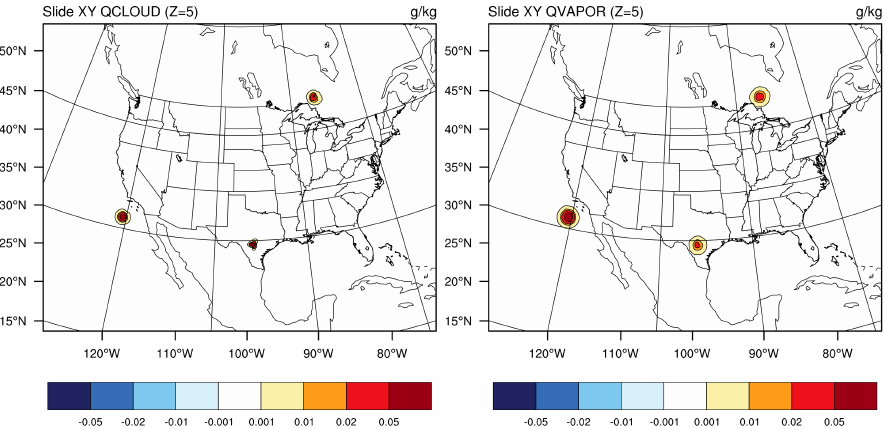
Figure 17. (a) Horizontal slide (vertical model level 5) of a pseudo observation test of cloud water condensate (innovation and observation error of 0.1gkg − 1 ) in a multivariate approach using the 3-D variance; (b) as a consequence, there is a positive increment on cloud vapor mixing ratio (WRF, res. 15km, D-ensemble,